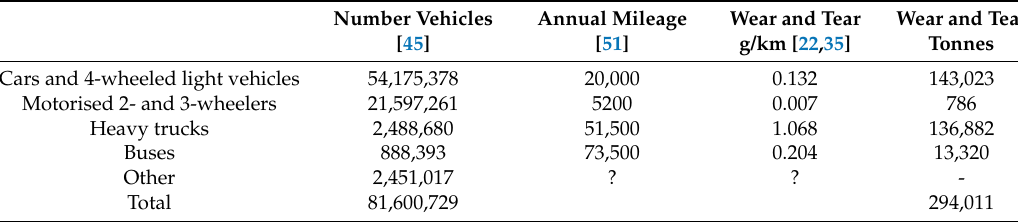
Table 12. Calculation of the amount of tyre wear and tear in Brazil